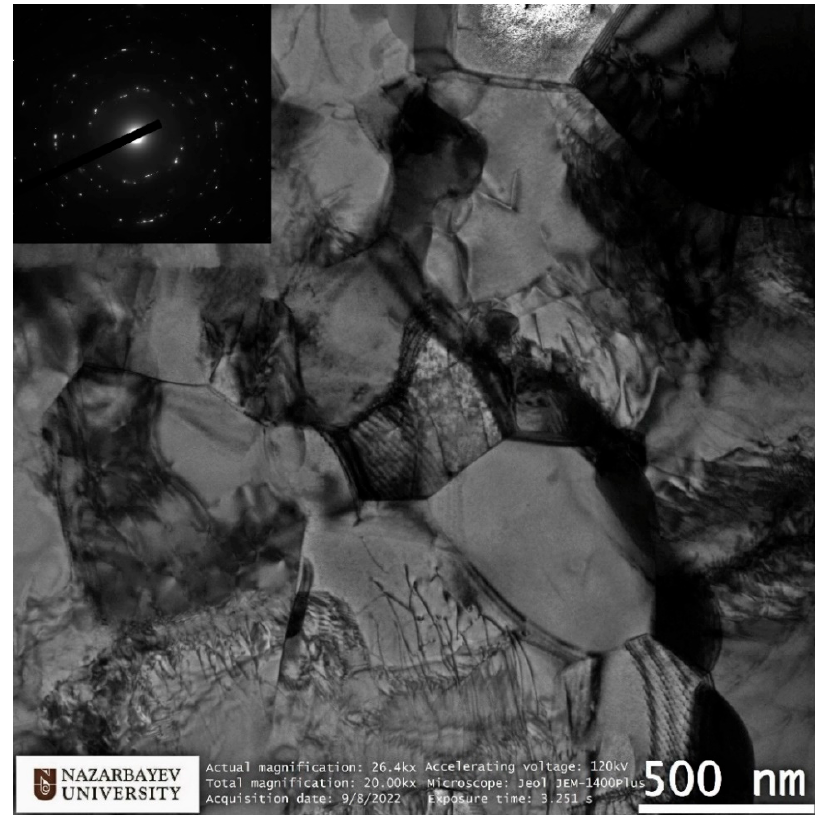
Figure 11. The central (axial) zone of the final rolled sample EBSD map.